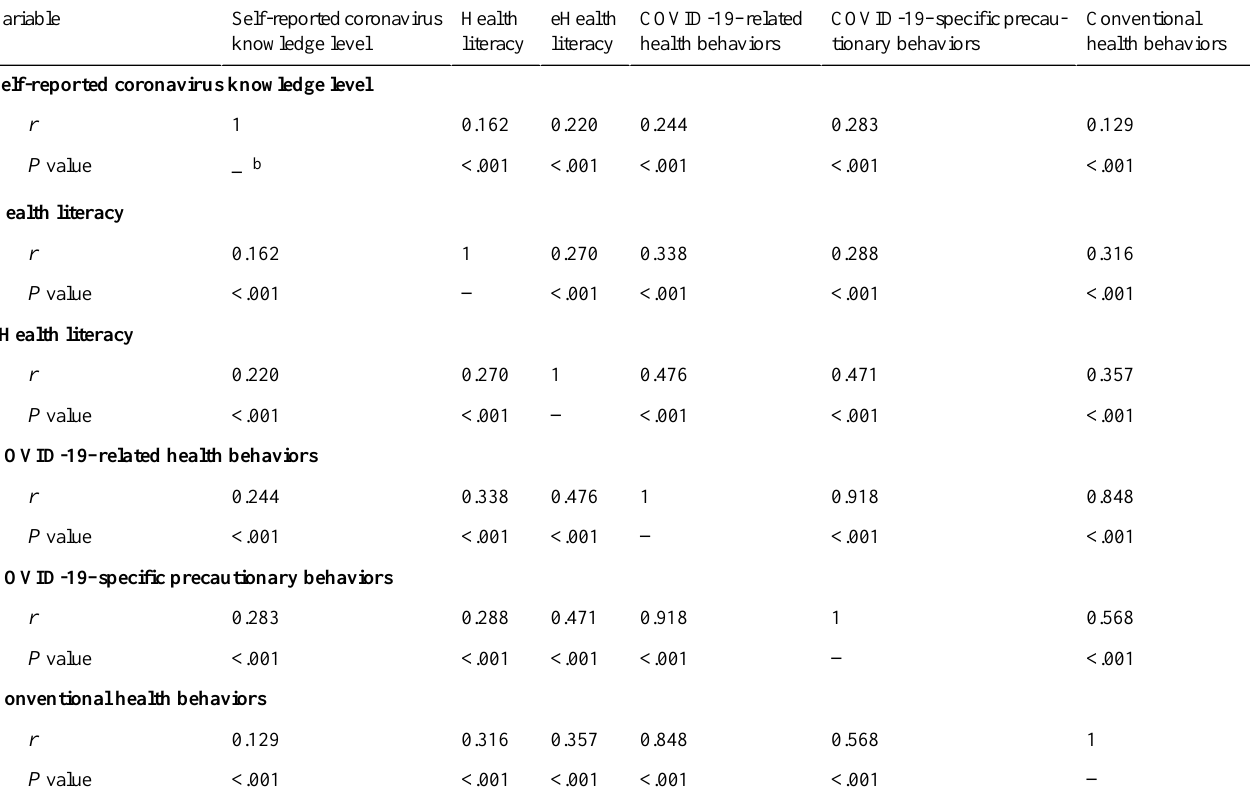
Table 3. Correlation matrix (Pearson r and two-tailed P value a ) of self-reported coronavirus knowledge level, health literacy, eHealth literacy, and health and precautionary